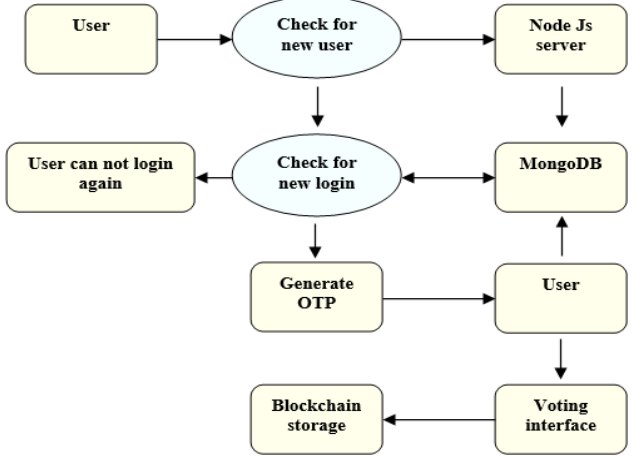
Figure 4. E-vote Figure 4. E-vote methodology.